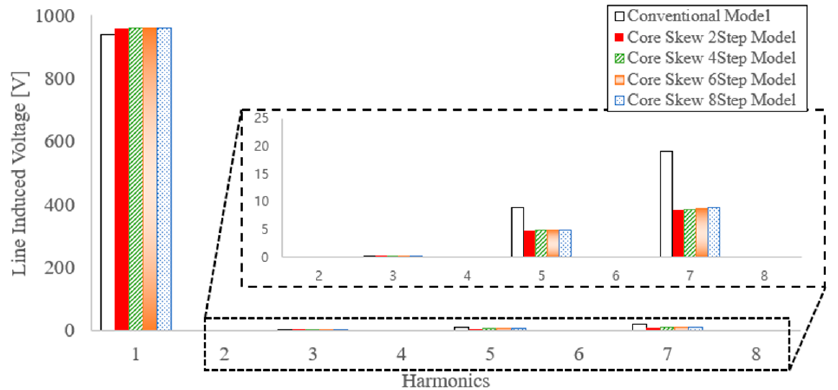
Figure 20. 15,660 rpm line-induced voltage spectra according to the number of steps.